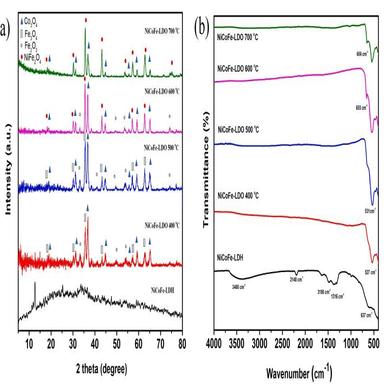
(a) XRD patterns and (b) FTIR spectra of NiCoFe-LDH and NiCoFe-LDO prepared at different temperatures.